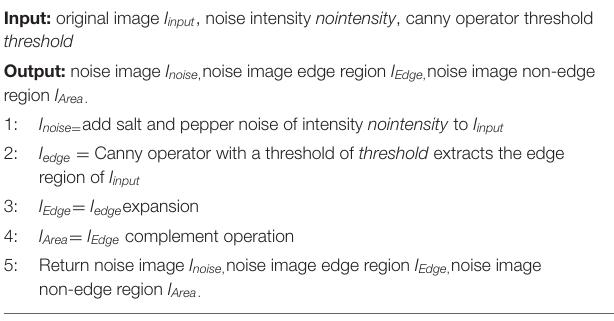
Algorithm 1 : Image preprocessing.